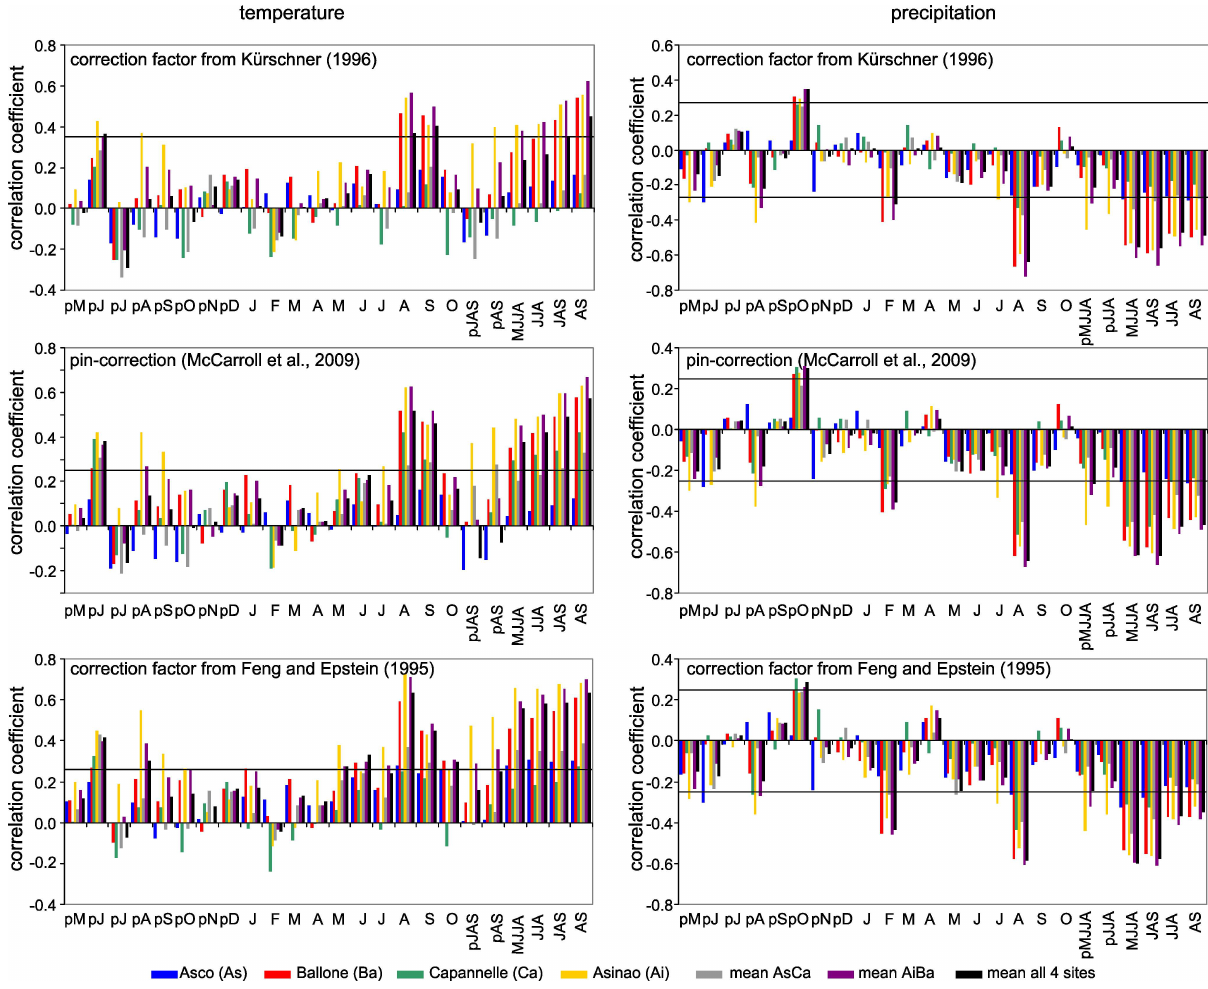
Fig. 2. Pearson correlation coefficients for differently corrected carbon isotope chronologies and mean monthly temperature (left panels) and mean precipitation (right panels) for the time period 1951–2000 plotted for an 18-months period from the previous May (pM) to October of the current year. The vegetation period lasts from May to October. Black horizontal lines represent the significance level ( p < 0.05).